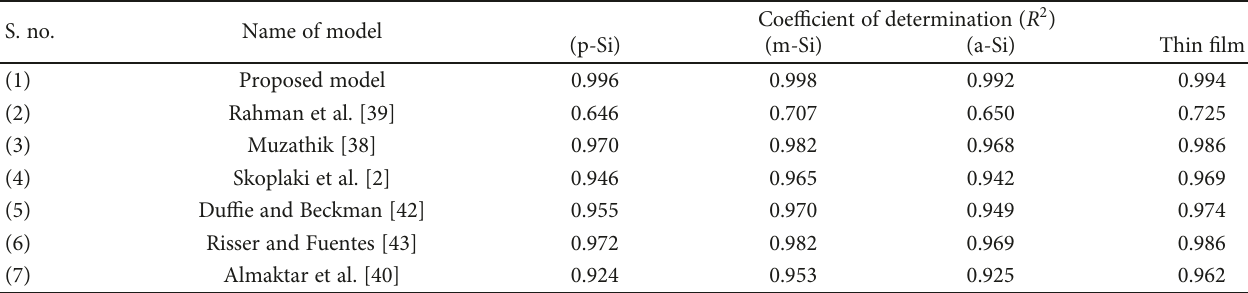
Table 6: Coe ffi cient of determination ( R 2 ) of each PV module in winter.